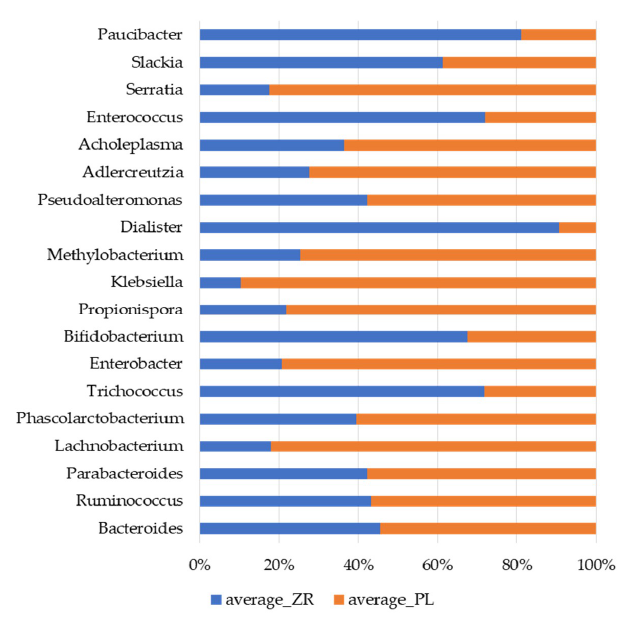
Figure 5. Relative proportions (percent) of genera showing significant ( p < 0.05) differences between the fecal samples of treated patients (ZR) and those of placebo (PL) patients.